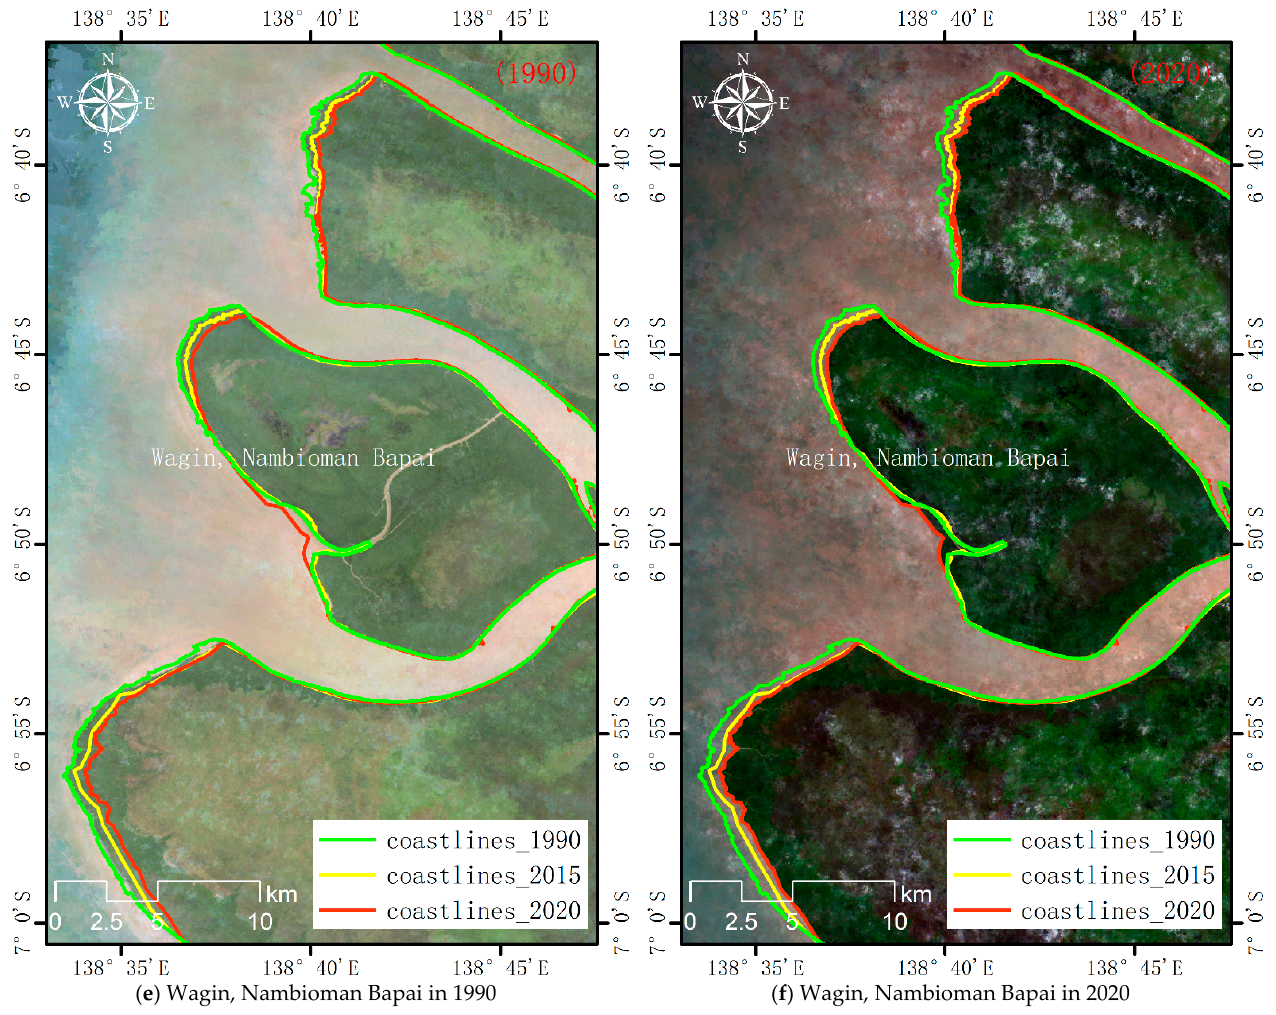
Figure 11. Natural evolution demonstration area.